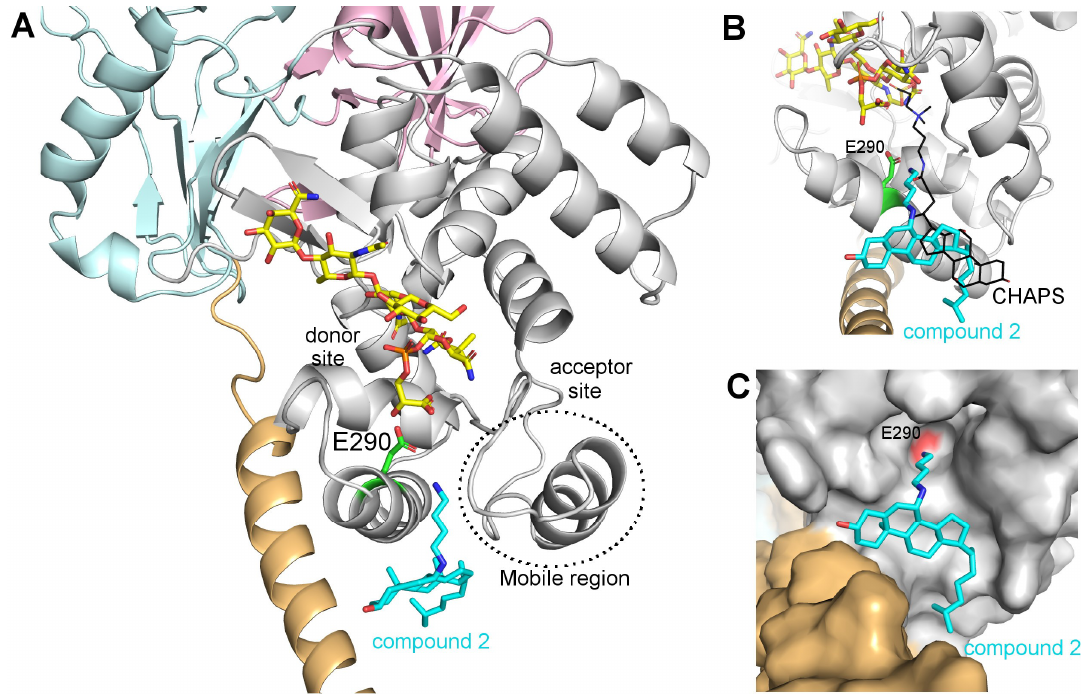
Figure 4. Model of the potential binding mode of compound 2 on the GTase domain of PBP1b (PDB code 5HLB). ( A ) Cartoon representation of PBP1b, with the TGase domain in grey, the trans-membrane segment in pale orange, the UB2H domain in pink and the TPase domain in blue. Moenomycin A and compound 2 are represented as yellow and cyan sticks respectively. The catalytic E290 is shown as green sticks. ( B ) Same as ( A ) with a rotation of approximately 90° and a CHAPS molecule represent as back lines. ( C ) Same as ( B ) with PBP1b represented as a surface. The red patch indicates the position of the accessible O from E290.